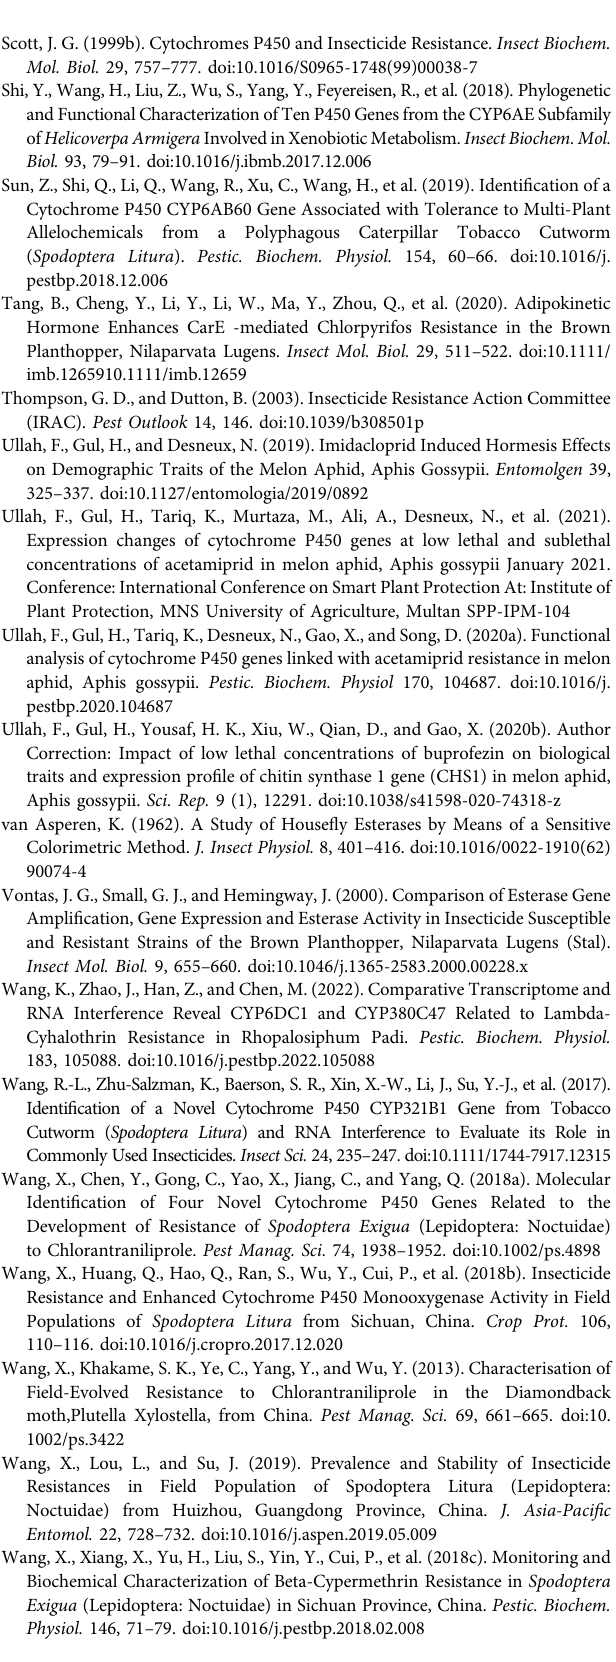
Exigua (Lepidoptera: Noctuidae) in Sichuan Province, China. Pestic. Biochem. Physiol. 146, 71 – 79.